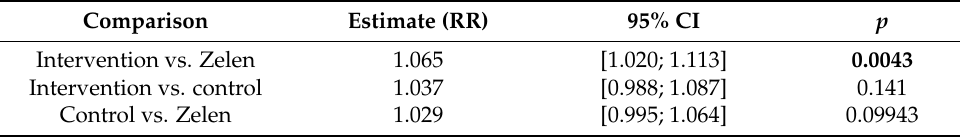
Table 3. Comparison of the three groups after intervention.